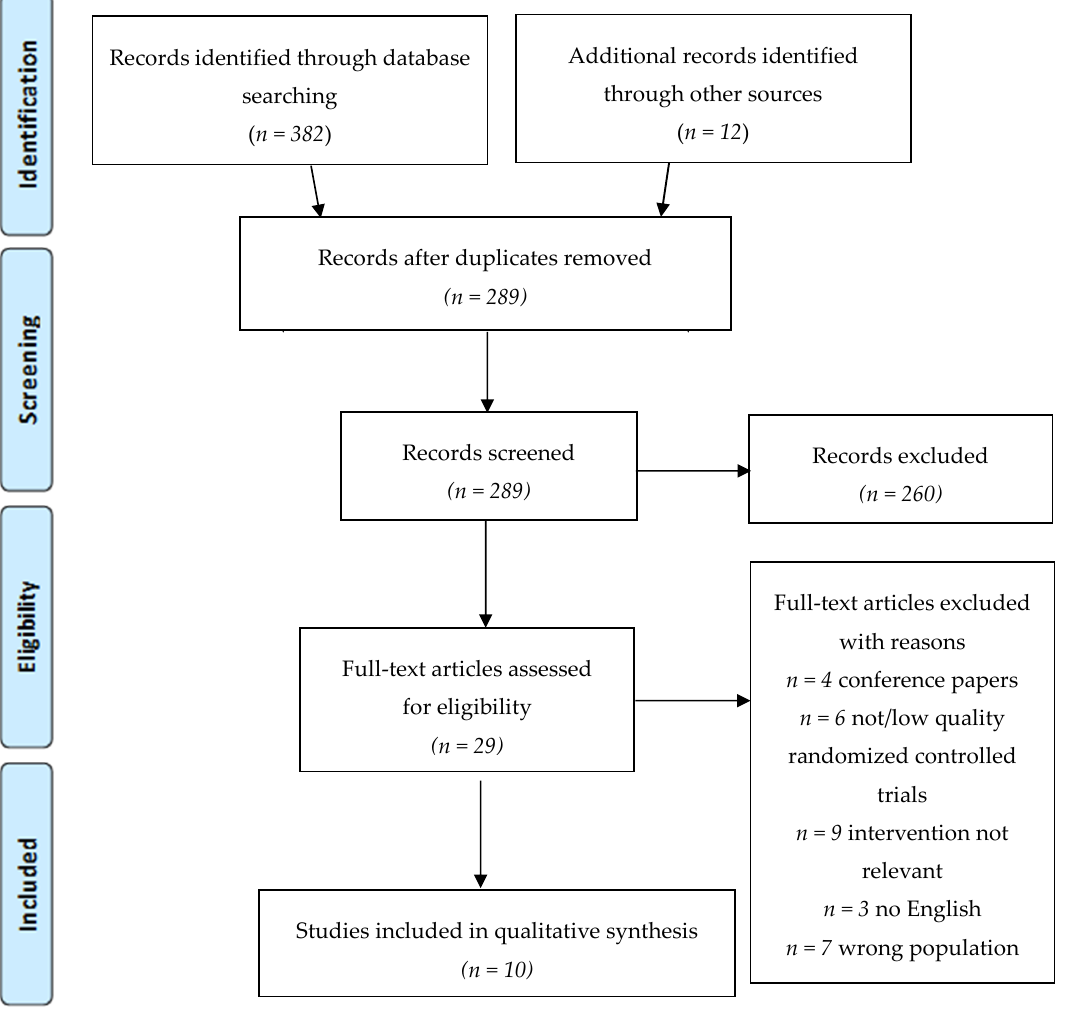
Figure 1. Flowchart of the article selection process (2009 Preferred Reporting Items for Systematic Reviews and Meta-Analyses (PRISMA) flow diagram).